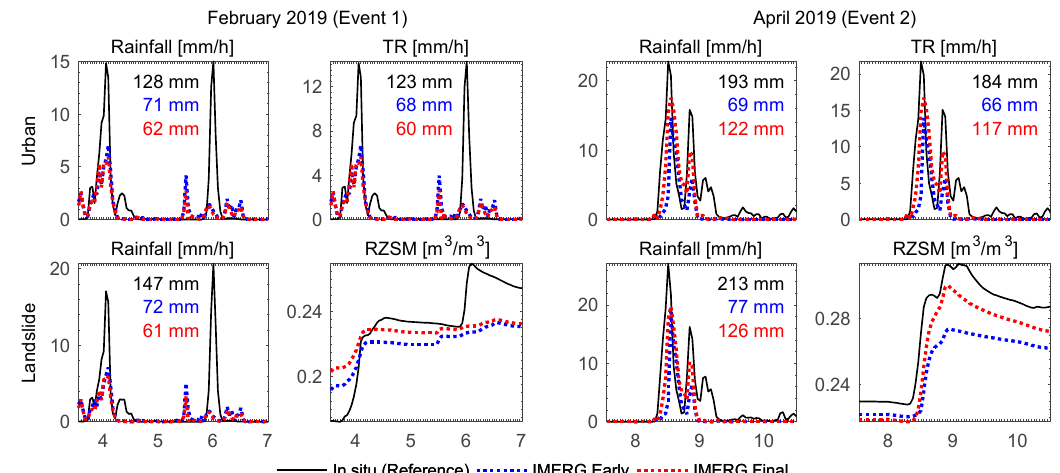
Figure 7. Selected storm events in Rio de Janeiro city and impacts on total runoff (TR) and rootzone soil moisture (RZSM) over urban (top) and landslide-prone (bottom) areas. Left panels show the evolution of the storm occurred from 5–7 February 2019 (Event 1), and right panels show the storm that occurred in 9–10 April 2019 (Event 2). Results are shown at the hourly time step and x-axes indicate days of the month.